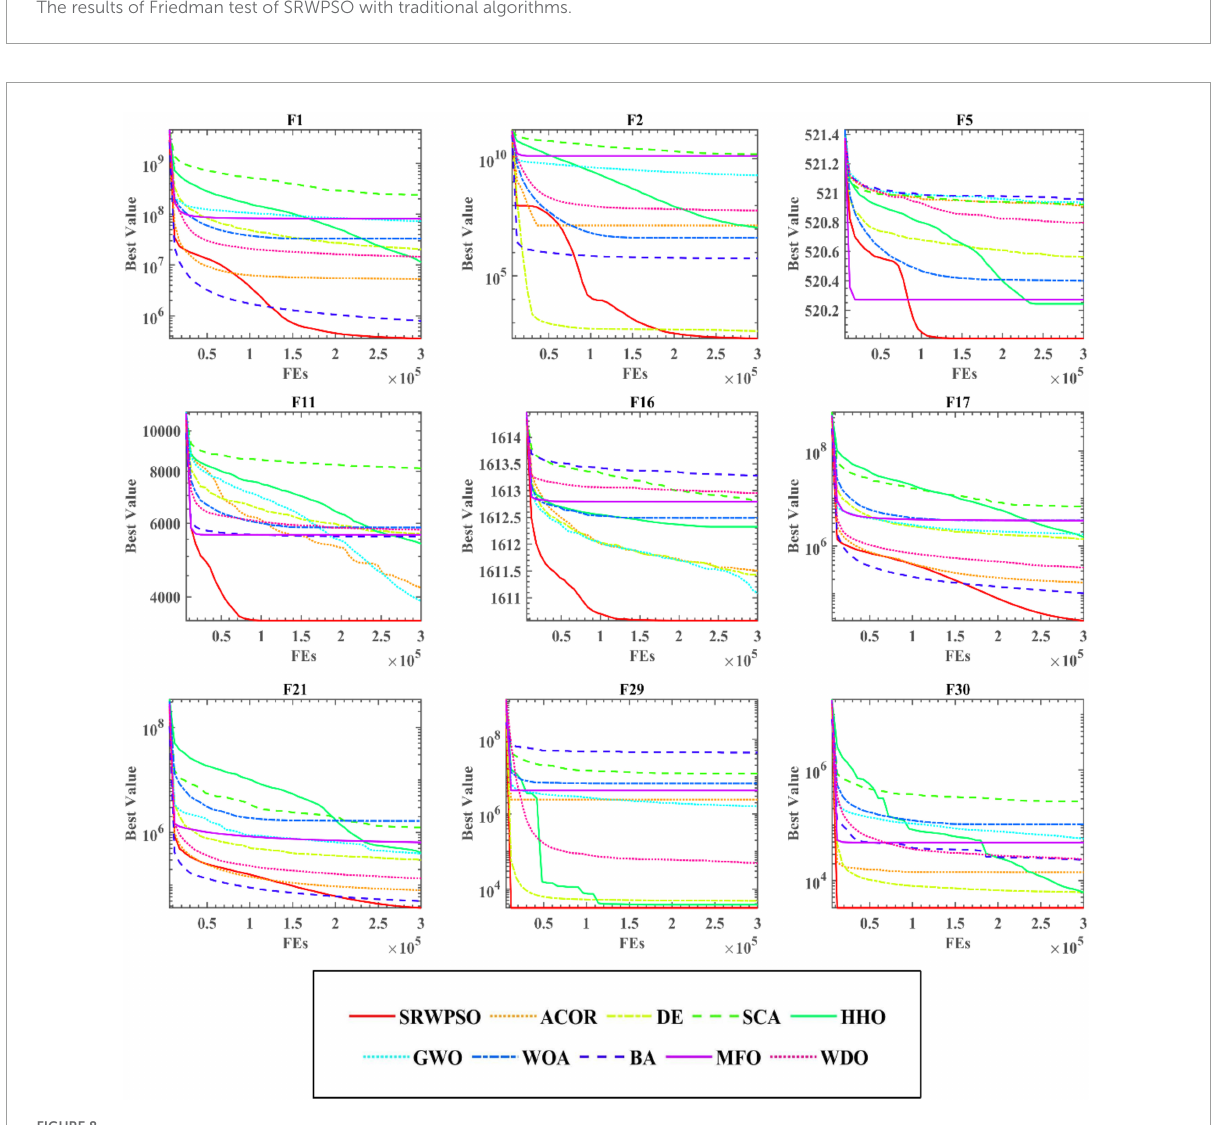
FIGURE8 The convergence curves of SRWPSO with traditional